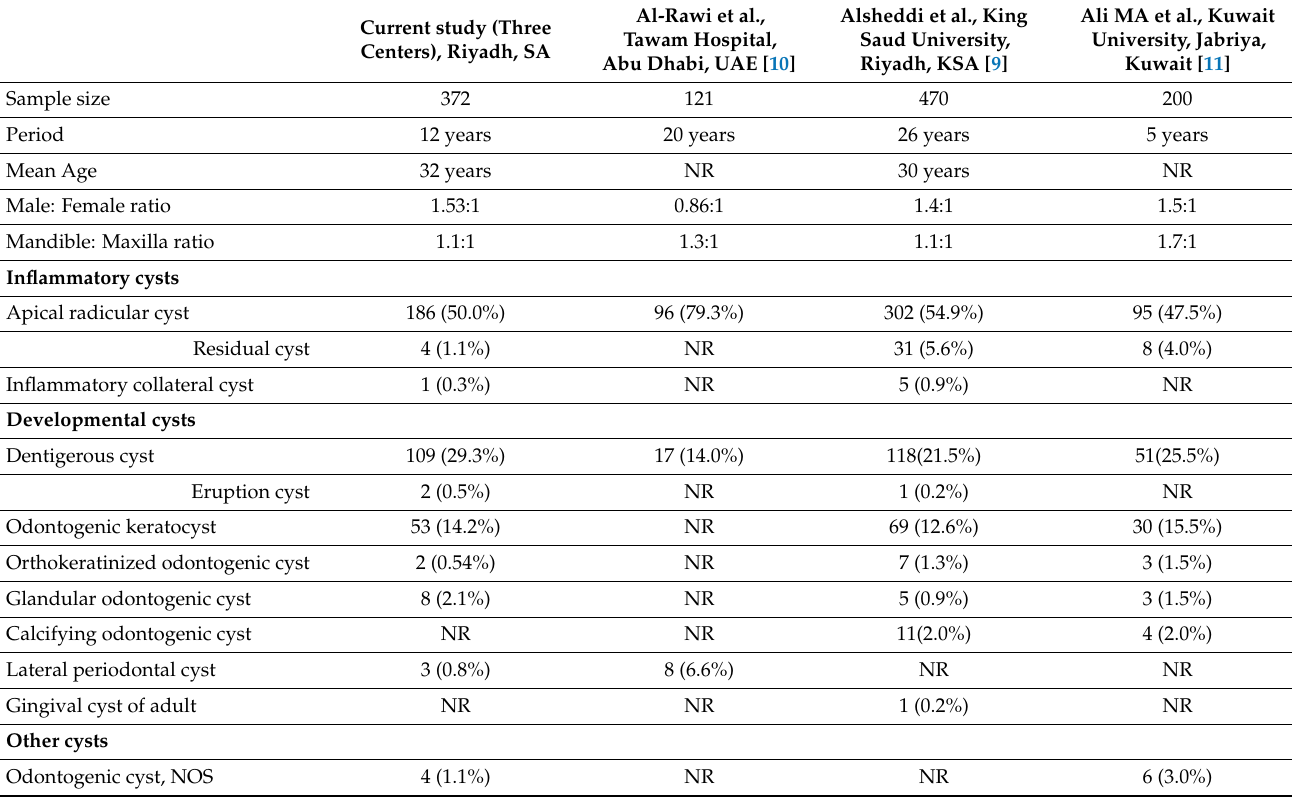
Table 7. Comparison of OC distribution in the current study and other Saudi and gulf